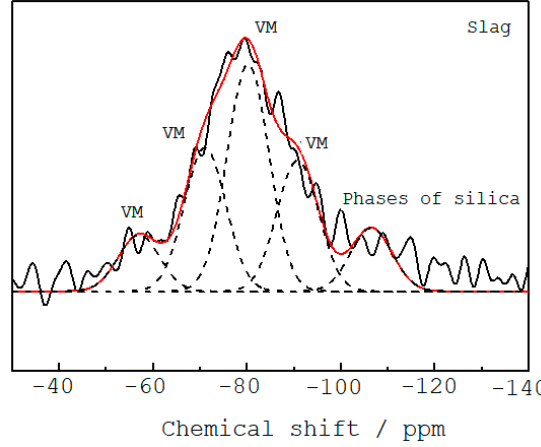
Figure 3. 29 Si NMR spectra of the raw materials. Table 1. Deconvolution of the 29Si MAS-NMR spectra.